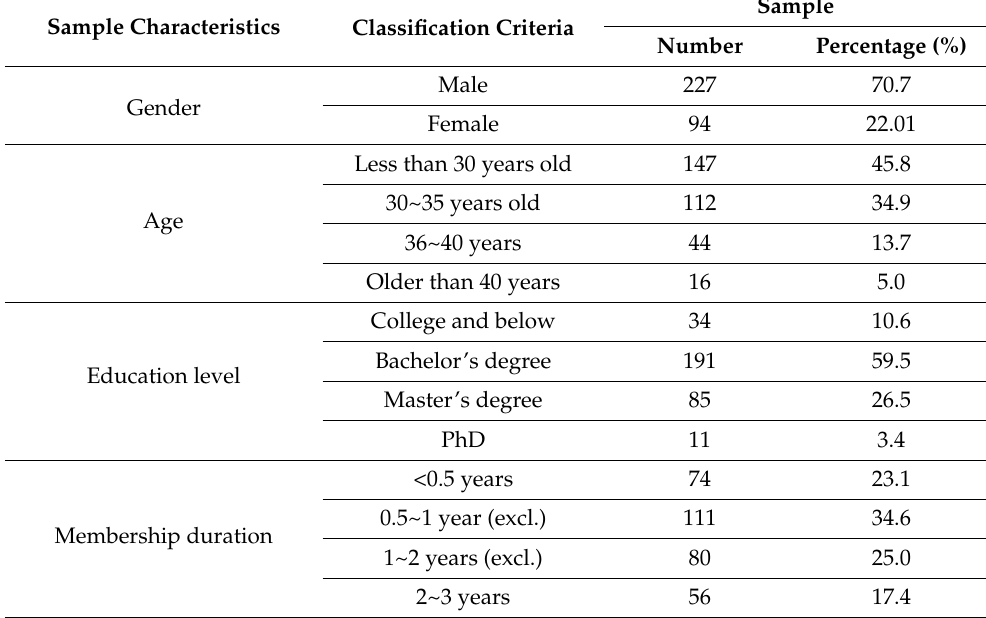
Table 1. Descriptive statistics of respondents (N =